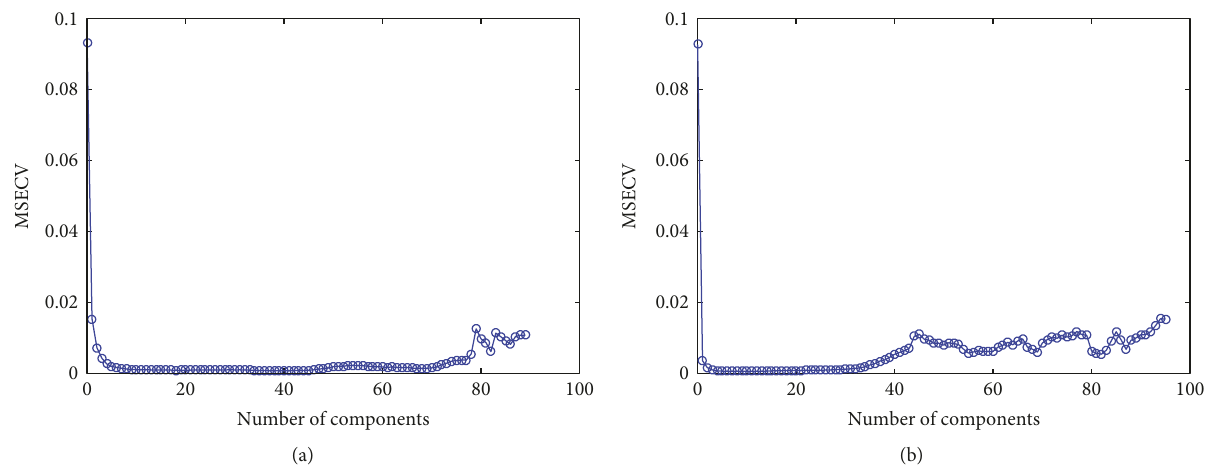
Figure 5: The correlation between the number of components and RMSECV for PLS. (a) Carbendazim and polyethylene mixture. (b) Carbendazim and rice powder mixture.